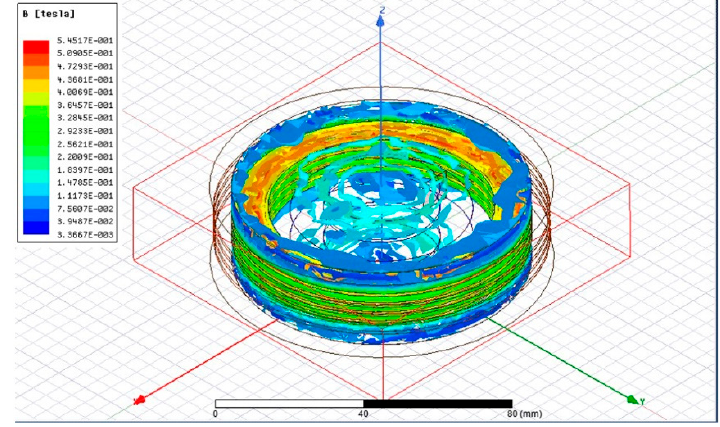
Figure 5. Simulation of magnetic flux density in the MRB.